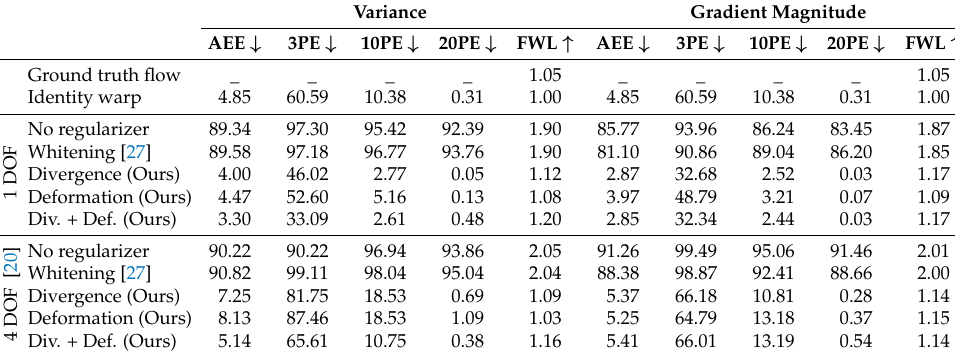
Table 1. Results of MVSEC dataset [44].